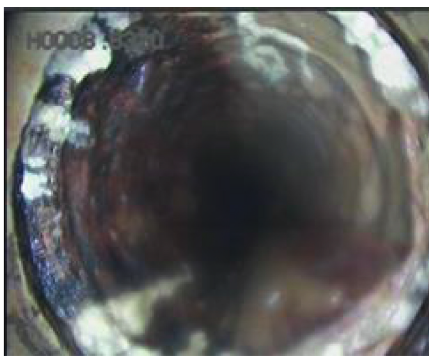
Figure 10: Pipe-pile joint monitored by camera technology in the hole.